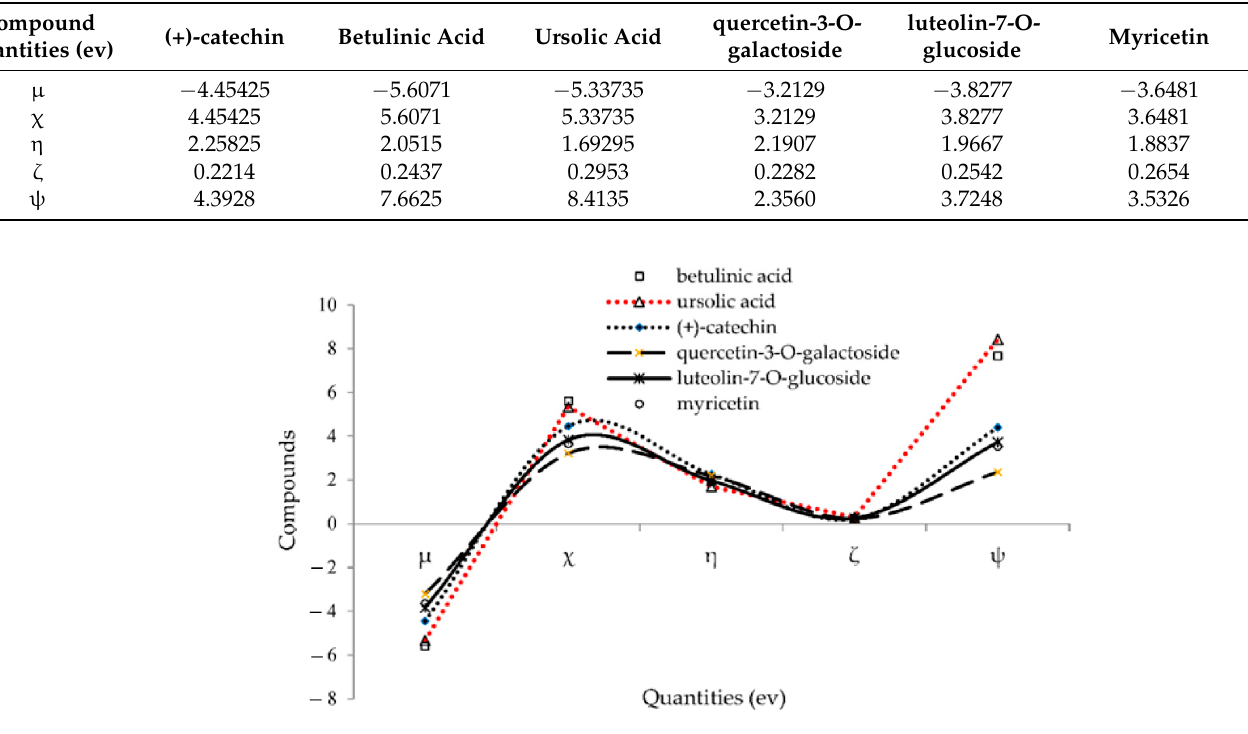
Figure 6. Changes in chemical potential ( µ ), electronegativity ( χ ), hardness ( η ), softness ( ζ ), elec- trophilicity index ( ψ ) for (+)-catechin, betulinic acid, ursolic acid, quercetin-3-O-galactoside, luteolin- 7-O-glucoside, and myricetin.